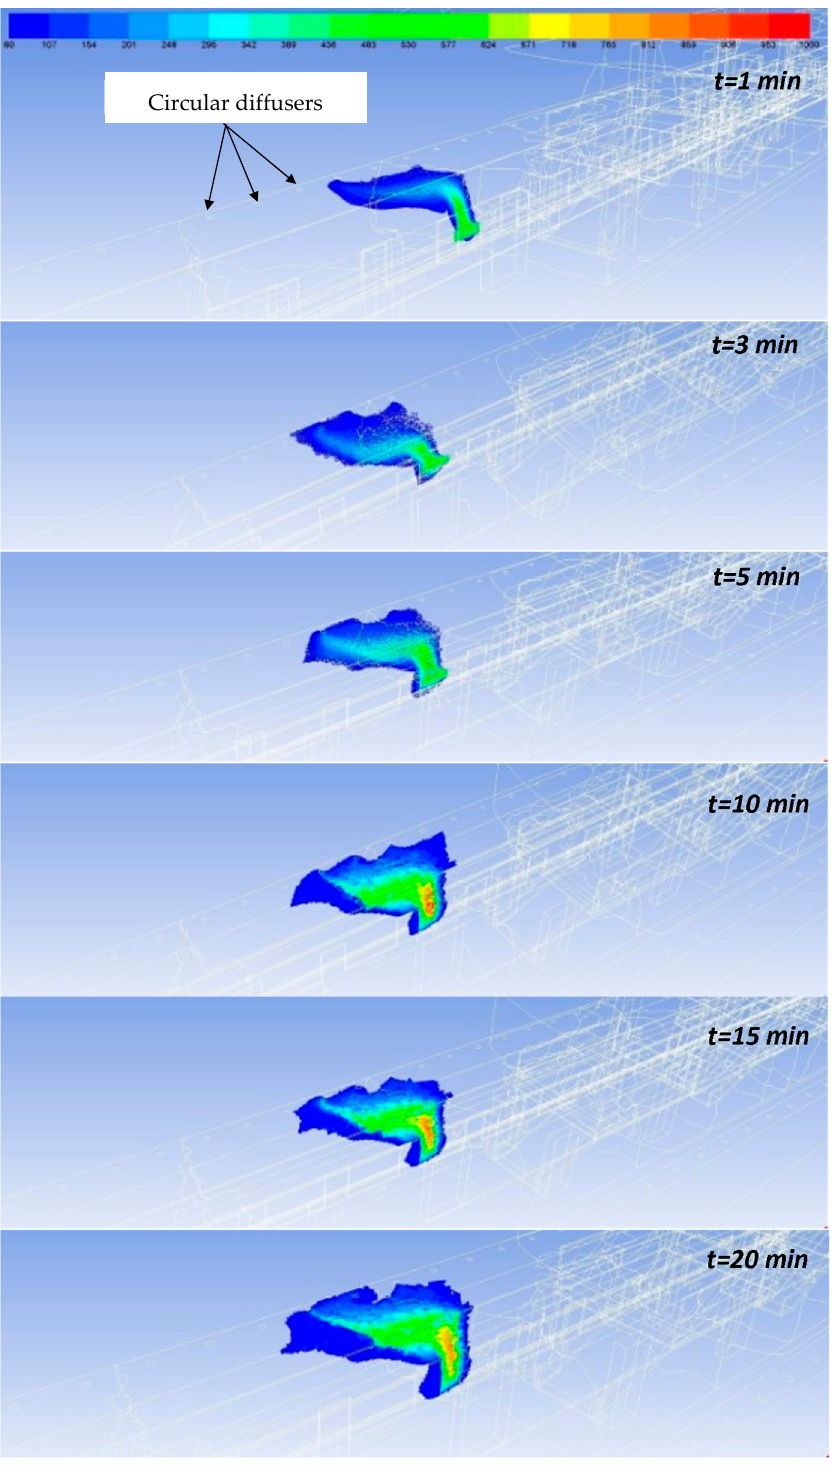
Figure 26. Temperature distribution (°C)—area above the fire outbreak.